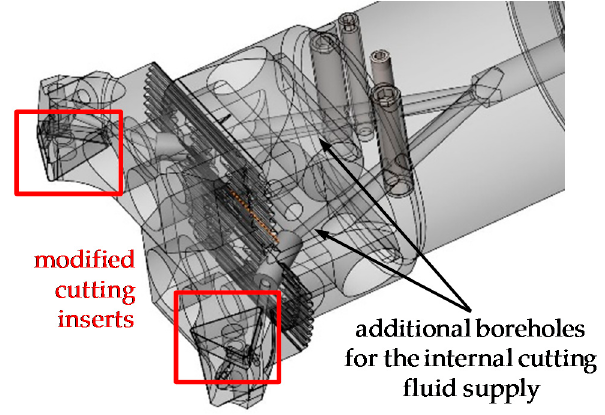
Figure 6. Adaption of tool holder for internal cooling.